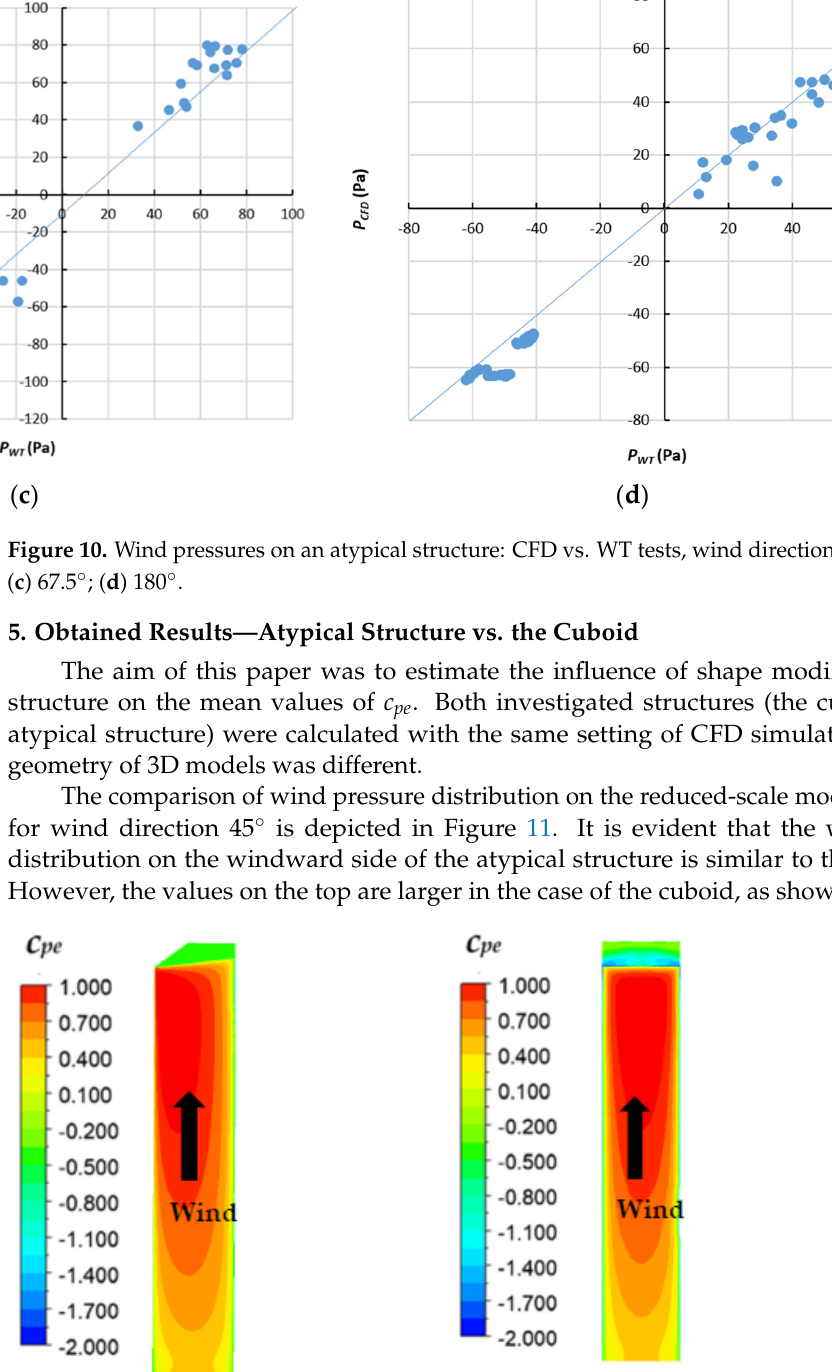
Figure 11. Mean external pressure coefficients (wind direction 45°). ( a ) Atypical structure; ( b ) the cuboid.